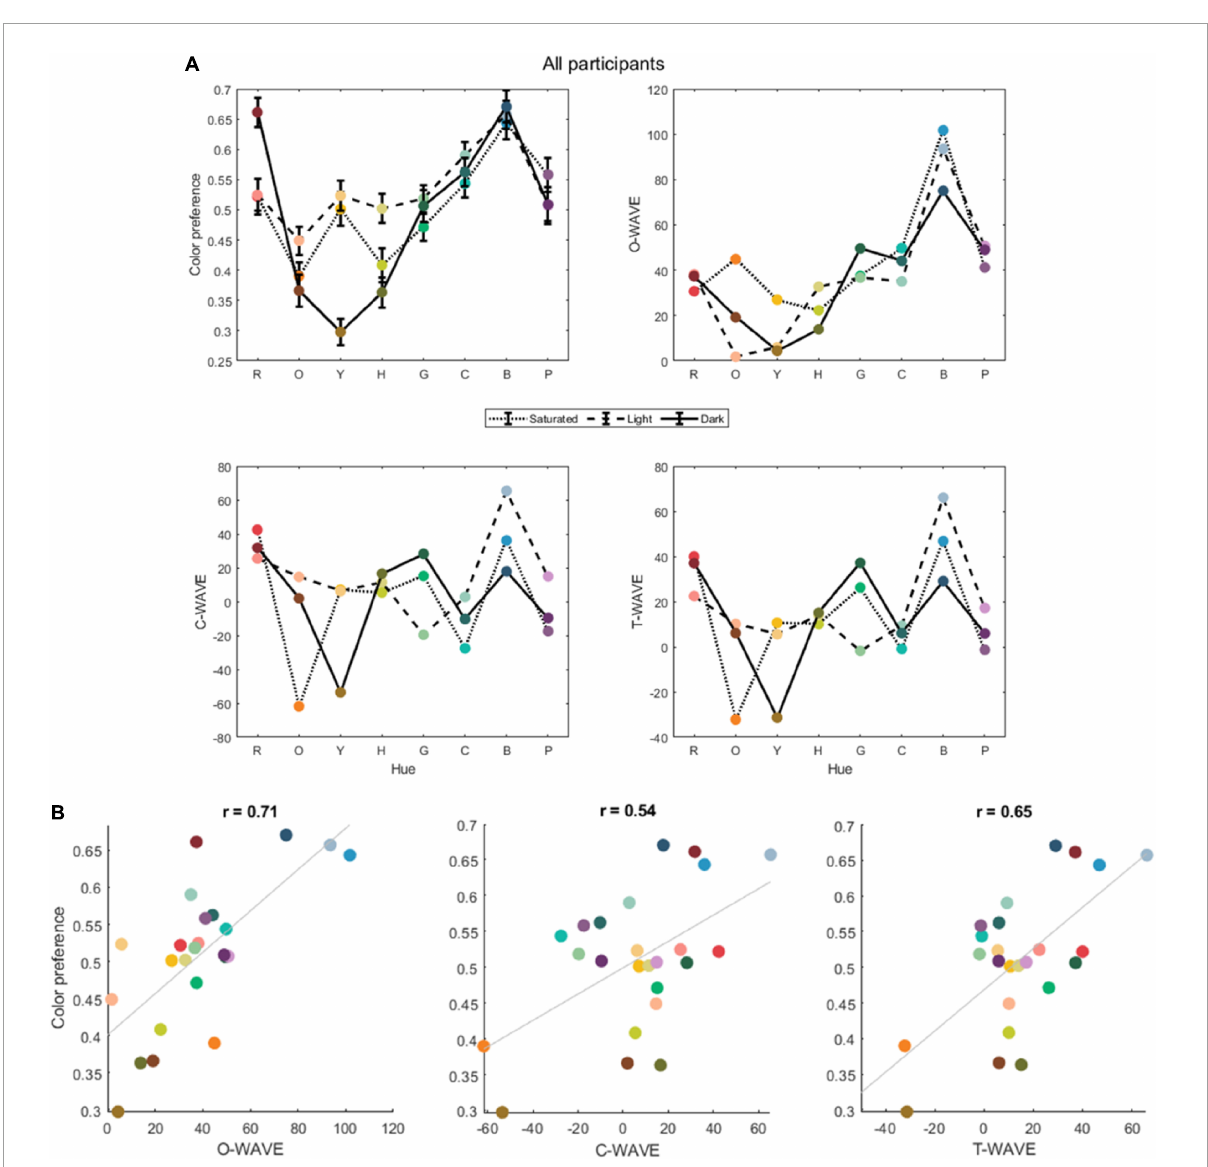
FIGURE1 (A) The average color preference rating and WAVEs for saturated (S), light (L), dark (D) versions of 8 hues, for object associations (O-WAVE), concept associations (C-WAVE) and both together (T-WAVE), for all participants. (B) The correlation plots between color preference and the three WAVE types: O-Wave, C-Wave, and T-Wave for all participants. Points are filled with color indicative of their appearance in the experiments, although note there are differences between display devices and so this is only an approximate